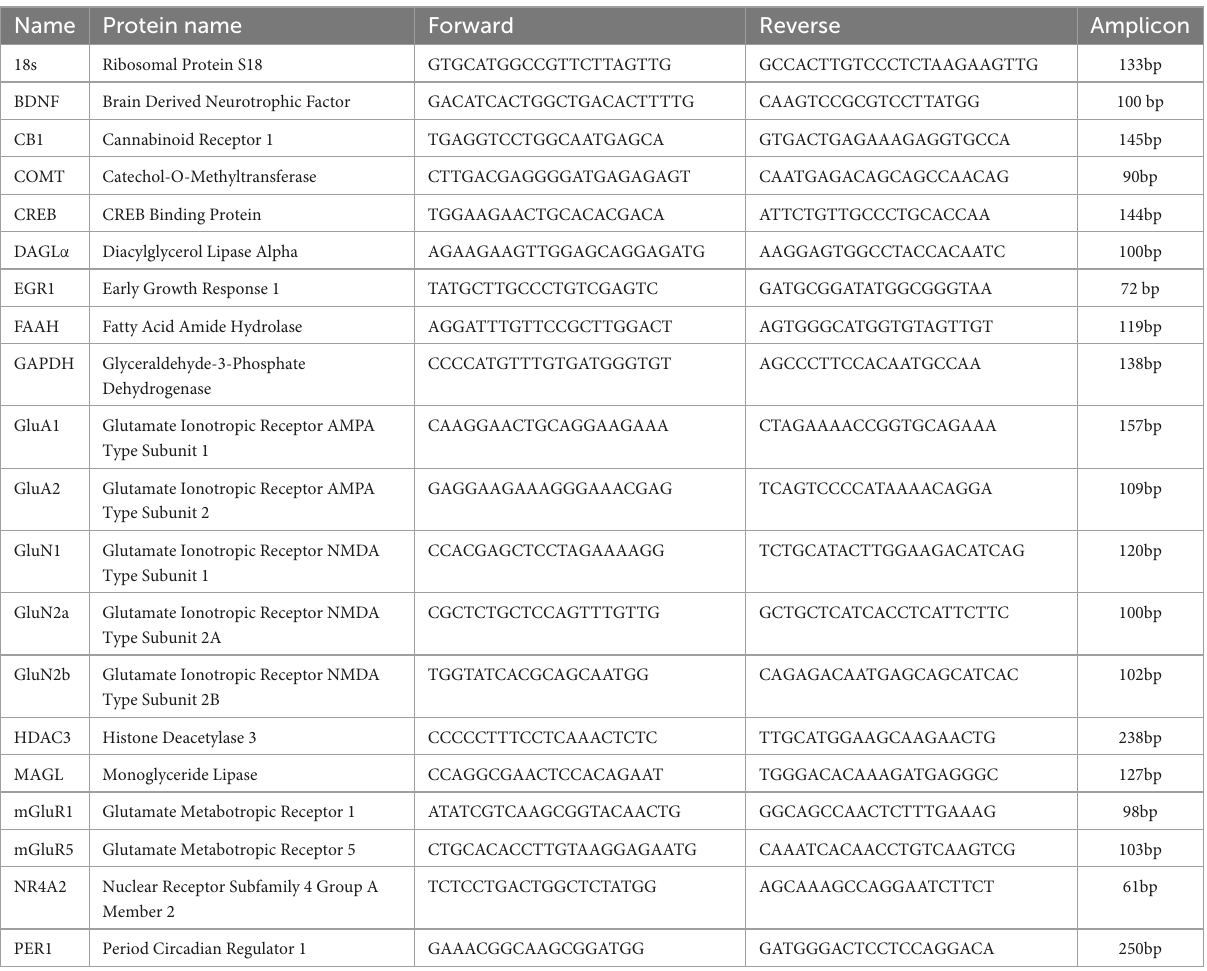
TABLE 1 qRT-PCR targets, primers, and amplicon